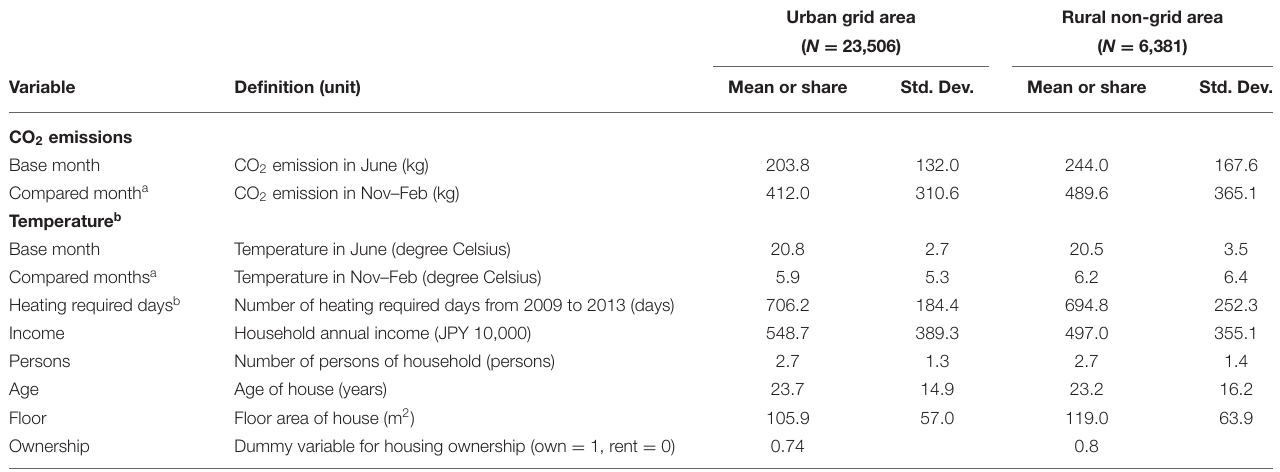
TABLE 2 | Descriptive statistics of